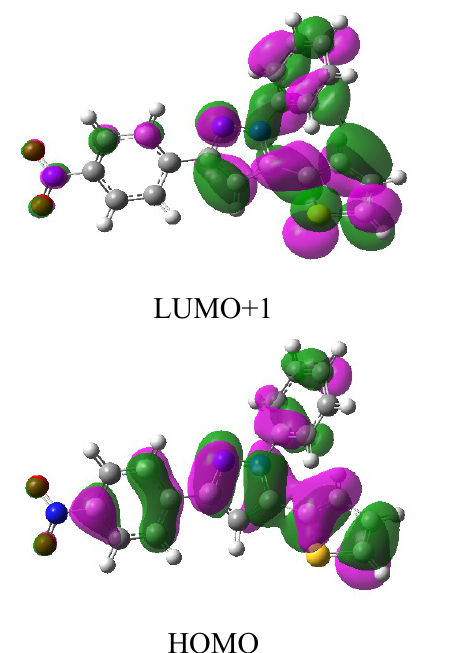
Figure 4. Some frontier molecular orbital stereographs for the title compound.